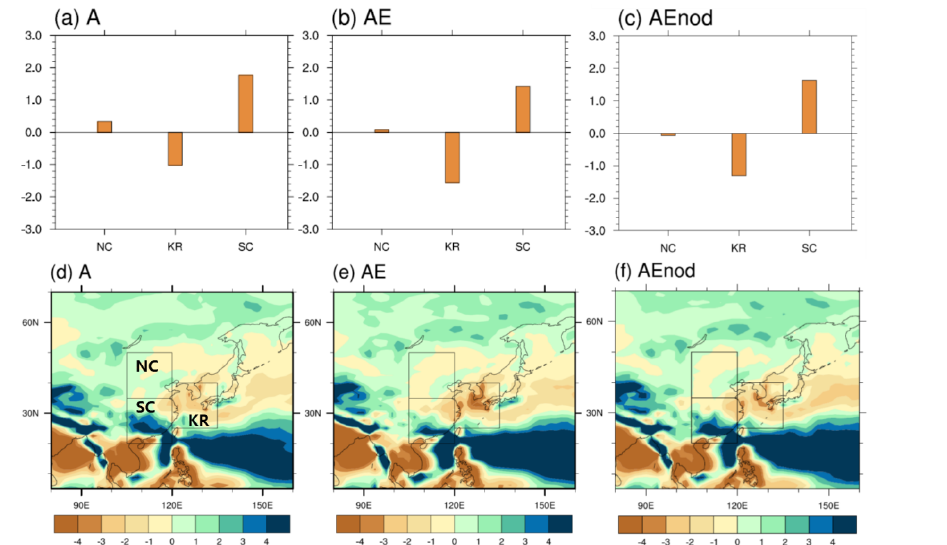
Figure 2. Area-averaged JJA precipitation bias (mmday − 1 ) compared to the Global Precipitation Climatology Project (GPCP) observation: (a, b and c) show regional mean biases over the regions shown in (d, e and f) . NC region: 35–50 ◦ N, 105–120 ◦ E; KR: 25–40 ◦ N, 120–135 ◦ E; SC region: 20–35 ◦ N, 105–120 ◦ E.